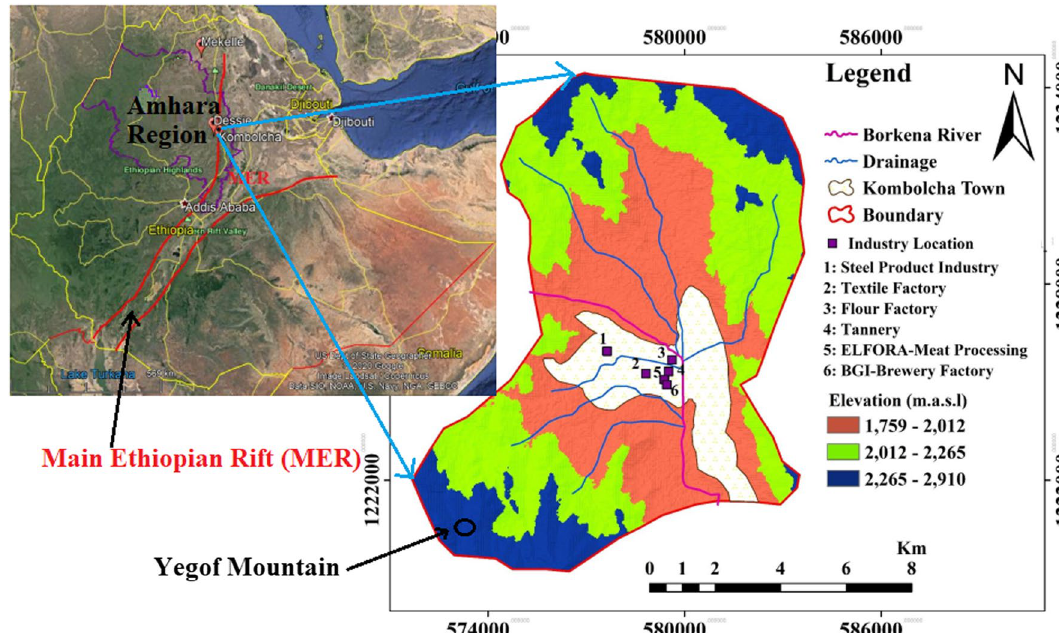
Fig. 1 Location map of the study area Fig. 2 Geological map (modi- fied after Geological Survey of Ethiopia GSE (2010) and water sampling point’s map of the study